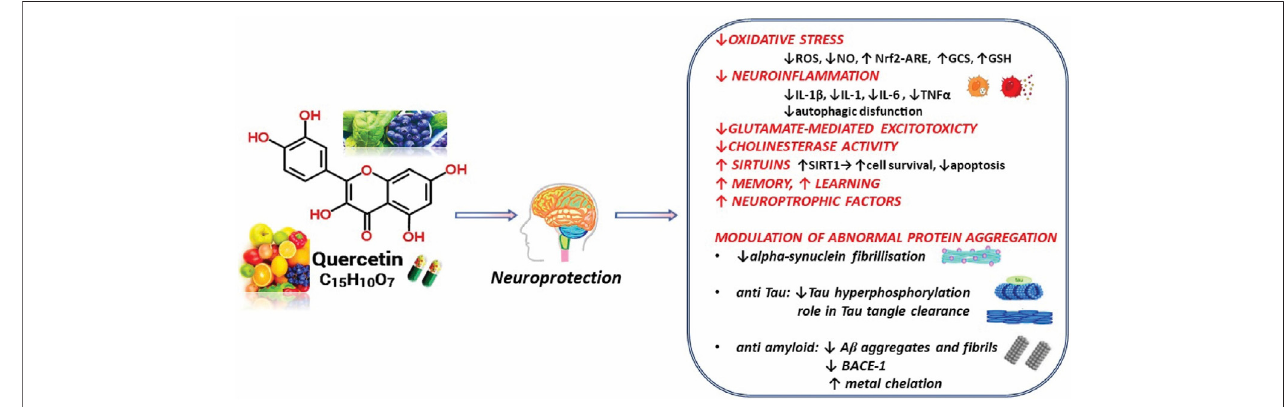
FIGURE 3 | Summarized scheme with relevant neuroprotective effects of Quercetin. Abbreviations: ↑ , increase; ↓ , decrease; A β , amyloid beta-peptide; BACE1, beta-secretase 1; GCS, γ -glutamyl-cysteine synthetase; GSH, glutathione; IL, interleukin; NO, nitric oxide; Nrf2-ARE, Nuclear factor erythroid-derived 2-like 2- antioxidant responsive element; ROS, reactive oxygen species; SIRT1, sirtuin 1; TNF- α , tumor necrosis